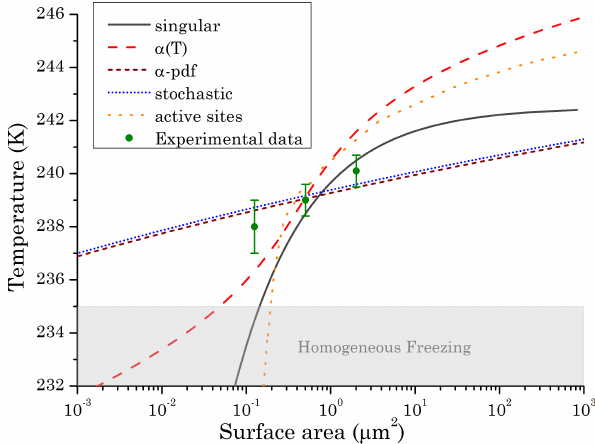
Fig. 10. Surface area dependent median freezing temperature i.e. temperature at which a kaolinite particle with the corresponding sur- face area will nucleate ice in immersion mode with a probability of 50%. In a population of droplets this corresponds to 50% frozen droplets. Nucleation time is